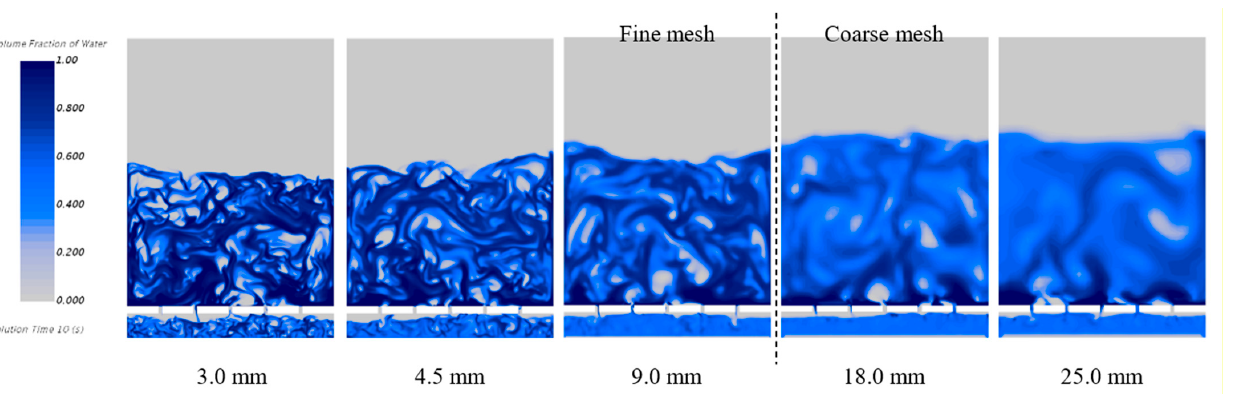
Figure 7. Volume fraction of water. Mesh independence study.